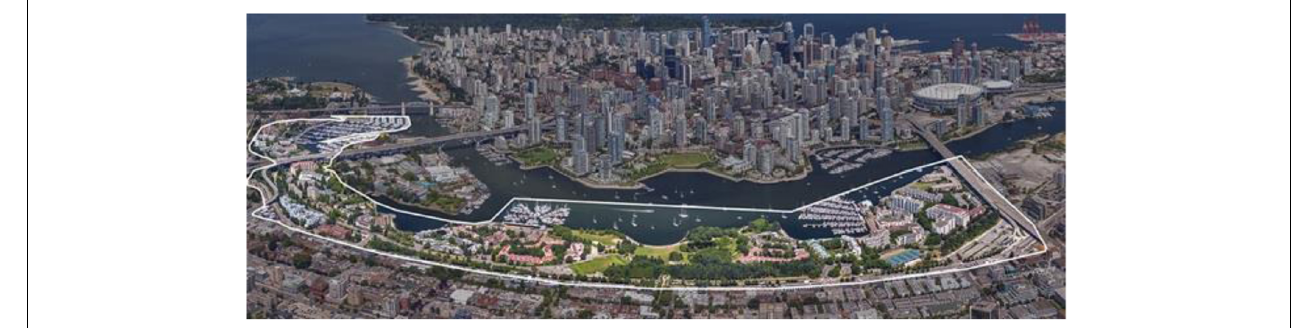
FIGURE 1 | False Creek South ( source : City of Vancouver; reprinted with permission).